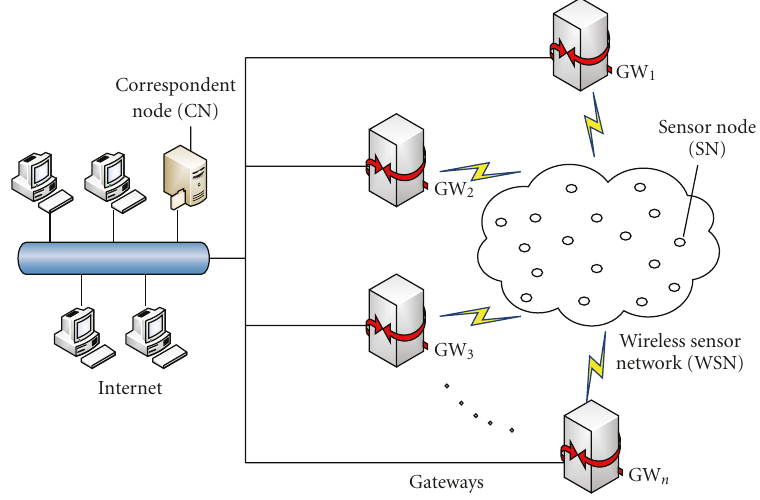
Figure 3: 6LoWPAN multiple gateway network